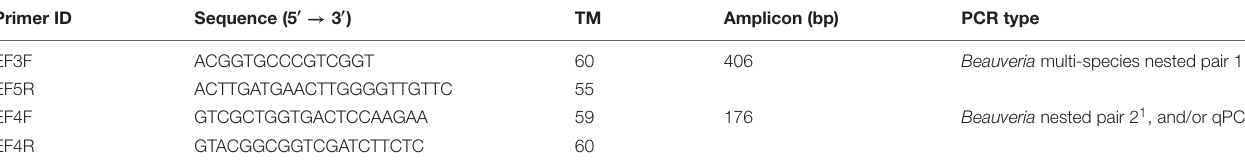
TABLE 2 | Novel primer pairs designed for a 2-step nested PCR